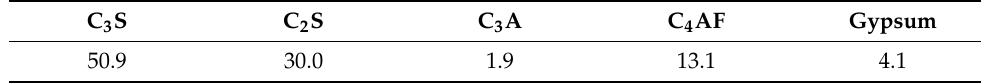
Table 2. Phase composition of Class G oil well cement